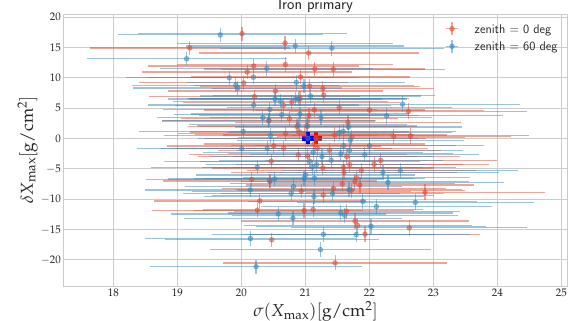
Figure 7. Results of simulations in [ σ ( X max ), δ X max ], iron pri- mary.